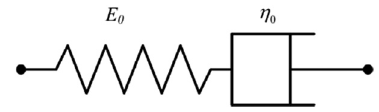
Figure 5: The structure features of the Maxwell model.